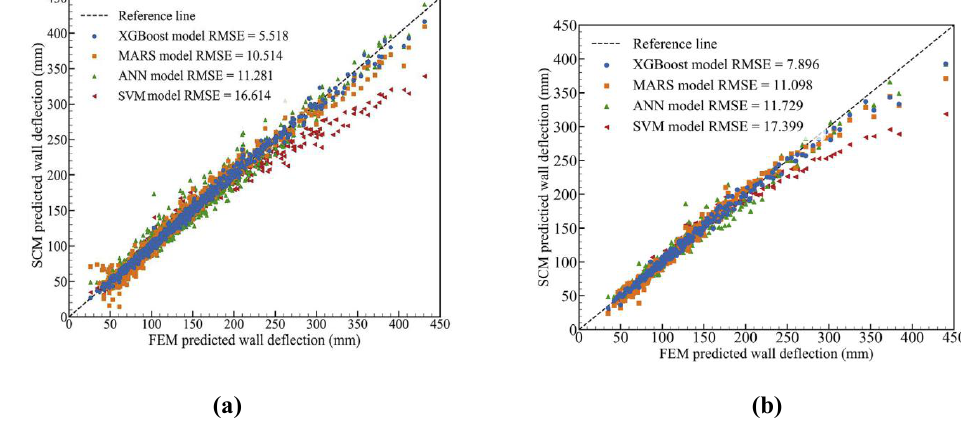
Figure 4. (a) Training and (b) Testing results of FEM wall deflection [6]